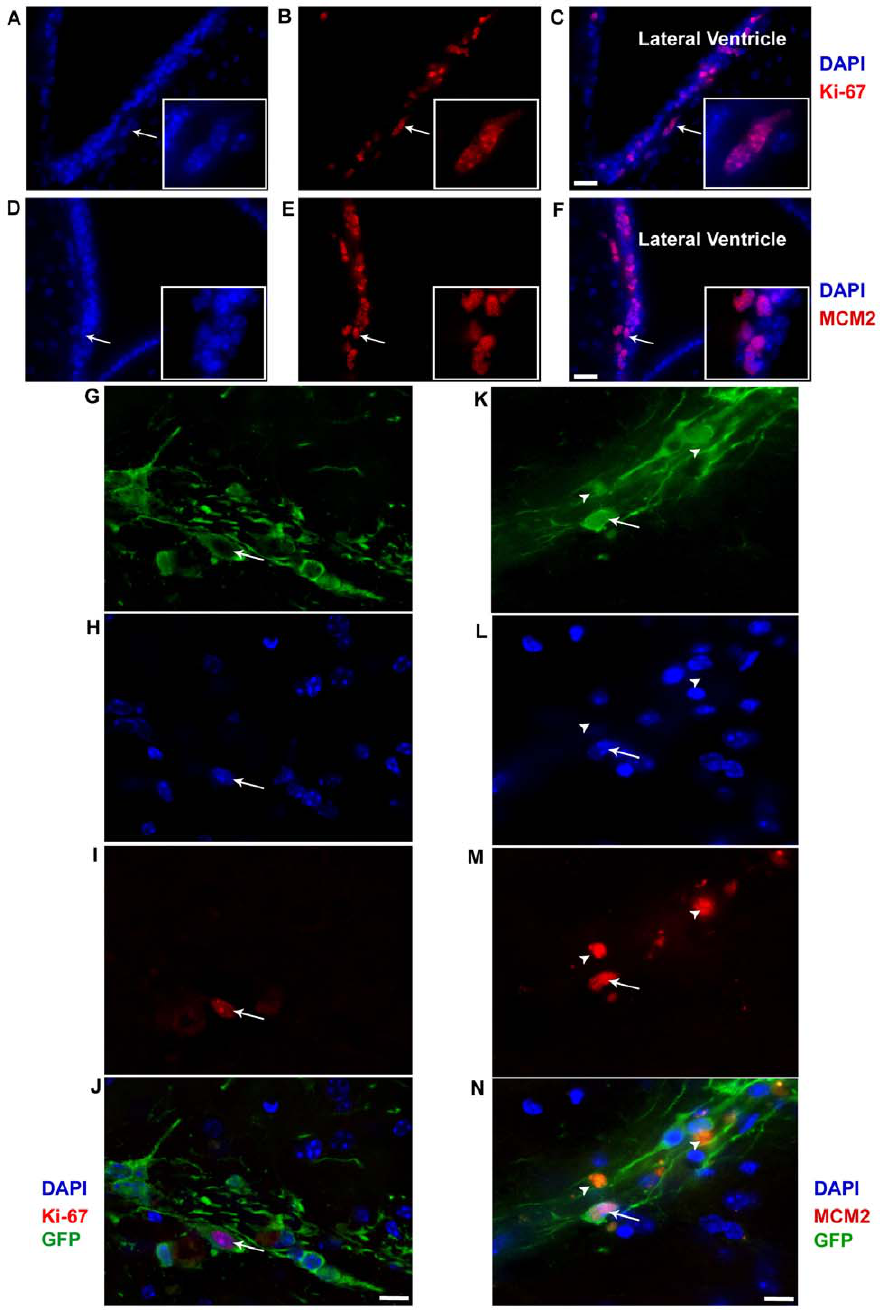
Figure 6. Representative confocal micrographs of sorted Tau-GFP positive immature neurons (P1 population) in NOD-SCID mouse striatum. ( A–C ): Ki-67 and ( D–F ): MCM 2 immunoreactive cells of the subventricular zone serve as an internal positive control. Co-localization of immunoreactive cells with DAPI shows that Ki67 and MCM2 are exclusively nuclear staining. ( G–J ) Ki-67 staining in transplant region shows a Ki-67 + / GFP 2 cell ( arrow ). ( K–N ) MCM2 staining in transplant region shows a MCM 2 + /GFP + cell ( arrow ) and two GFP + cells that do not have DAPI + nuclei but show red fluorescence ( arrow head ). The auto-fluorescent figures are probably clumps of dying or dead cell that show auto-fluorescence even before staining. Scale bars=20 m m for A–F , and 10 m m for G–N . Abbreviations: GFP=Green fluorescent protein, MCM2=Mini-chromosome maintenance protein. doi:10.1371/journal.pone.0020941.g006 neuronal circuitry in spinal cord injury [48,49], increasing axonal population of donor cells (e.g. 60% neurons, 40% glia or 90% sprouting in neonatal hypoxic ischemic brain injury [50], and neurons and 10% glia) which may provide the opportunity to delaying onset and progression of amyotrophic lateral sclerosis determine the cell type(s) responsible for a phenotypic change, to (ALS) [51]. Applying the methodology developed in this study to investigate the potential mechanisms, and adjust dosing strategies human neural stem cells, we hope to be able to define the starting based on a particular disease or disease stage. Application of